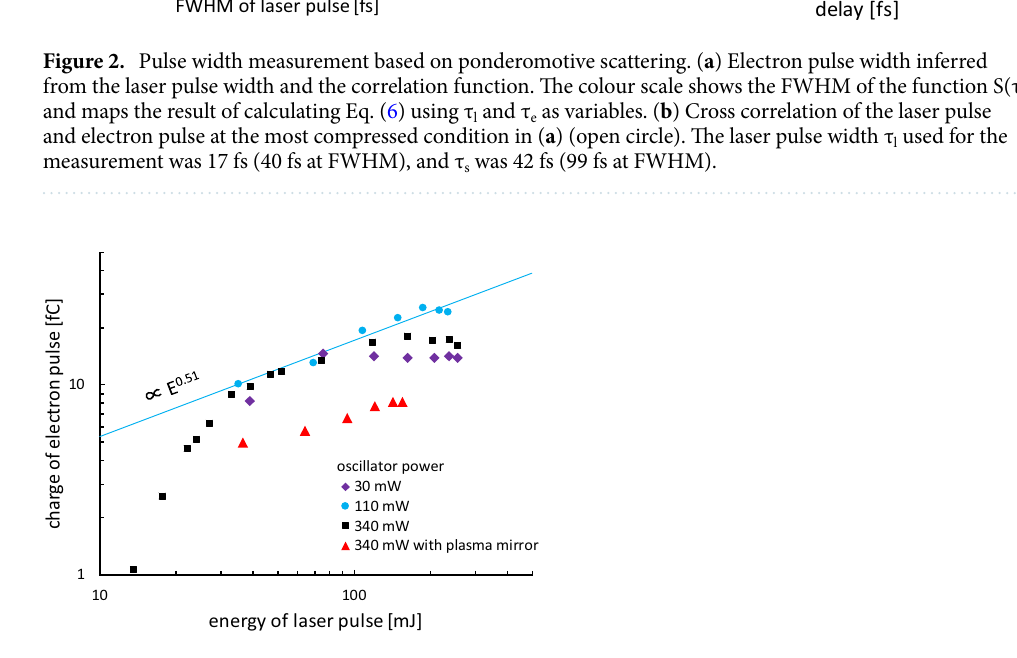
Figure 3. Laser pulse energy and contrast ratio dependence of the charge of the electron pulse. The charge of electron pulses with an energy of 375 keV detected using the fluorescent screen is plotted. To increase the charge, the pulse contrast ratio of the driving laser was adjusted by changing the input energy from the oscillator to the amplifier in the CPA laser system. For the input energy of 340 mW, the contrast ratio was 10 −7 . The input energies of 30 and 110 mW correspond to changing the contrast ratio by 11-fold and 3.1-fold compared with contrast ratio at an input energy of 340 mW. The results obtained using a plasma mirror 48 , which improved the contrast ratio from 10 −7 to 10 −9 , are also shown (see